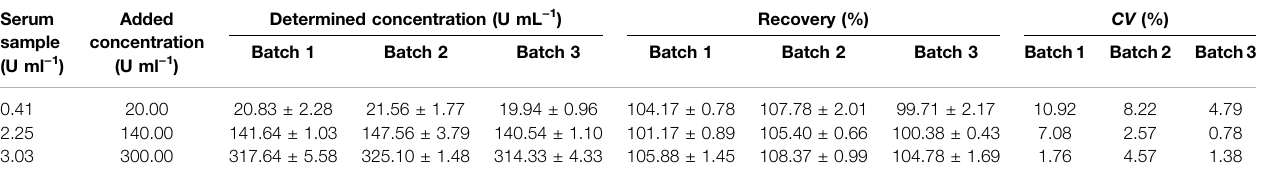
TABLE 3 | Recovery of CA50 in the normal human serum (n = 3). Serum sample